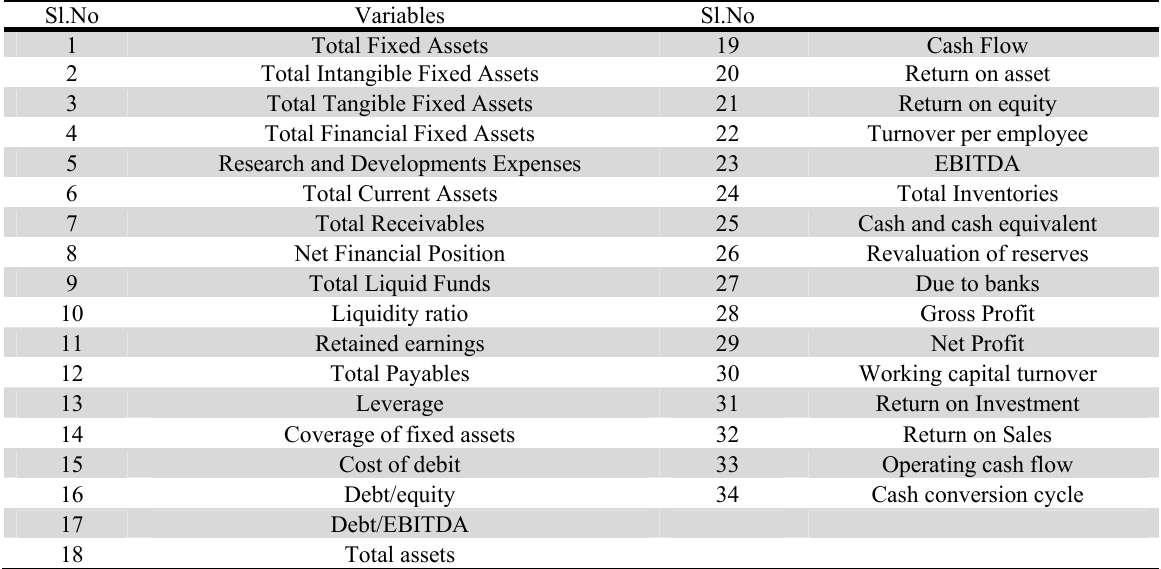
List of Variables Tested in the study to find the optimal model (Source:Aida, Bureau Van Dijk) Sl.No Variables